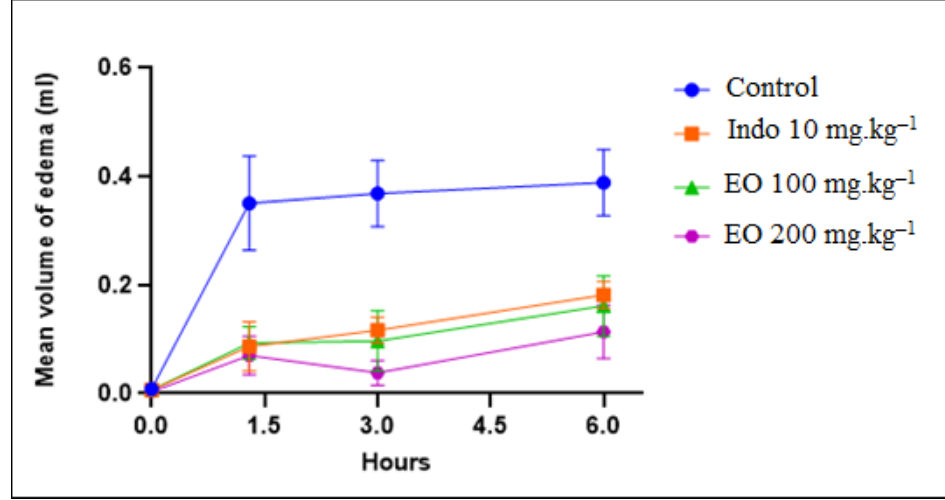
Figure 3. Influence of Thymus leptobotrys Murb essential oil (100 and 200 mg kg −1 ) on carrageenan-induced edema. Data represent the difference in mean edema volume (mean ± S.E.M), p ≤ 0.001 compared to the control. Indo: Indomethacin; EO: Essential oil.